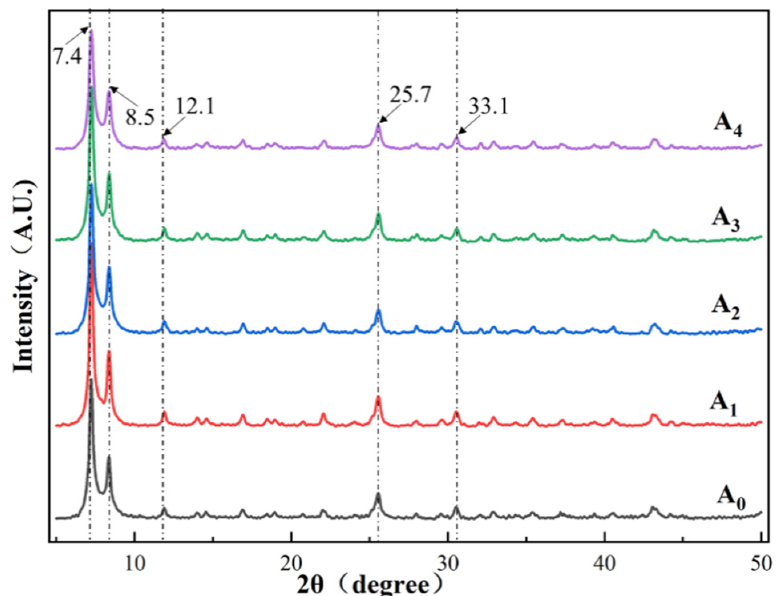
Figure 3. X-ray diffractometer (XRD) patterns of UiO-66-NH 2 synthesized under conditions of varying silver doping